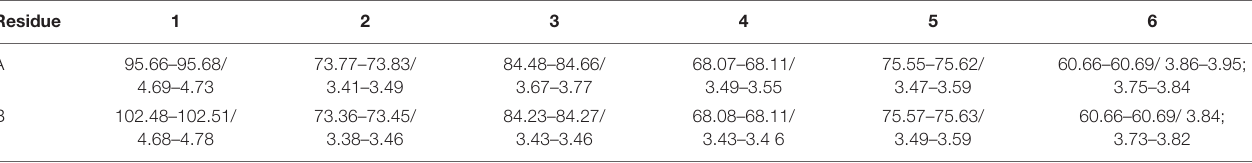
TABLE 2 | 1 H nuclear magnetic resonance (NMR) and 13 C NMR chemical shifts of laminaran oligosaccharides DP2-DP5 (D 2 O, δ in ppm).